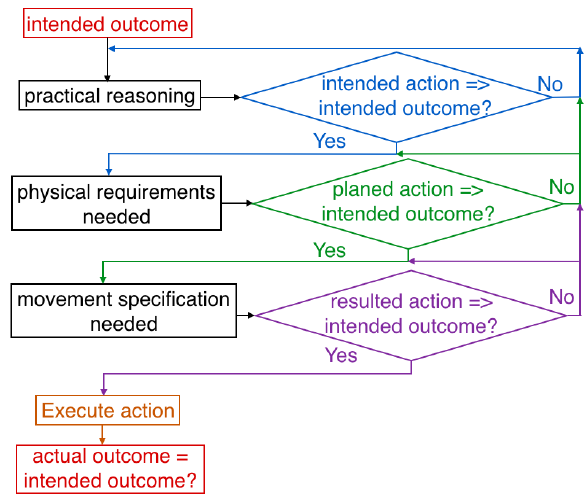
Figure 2: Simplified schematics of the mental process behind plan- ning a specific action